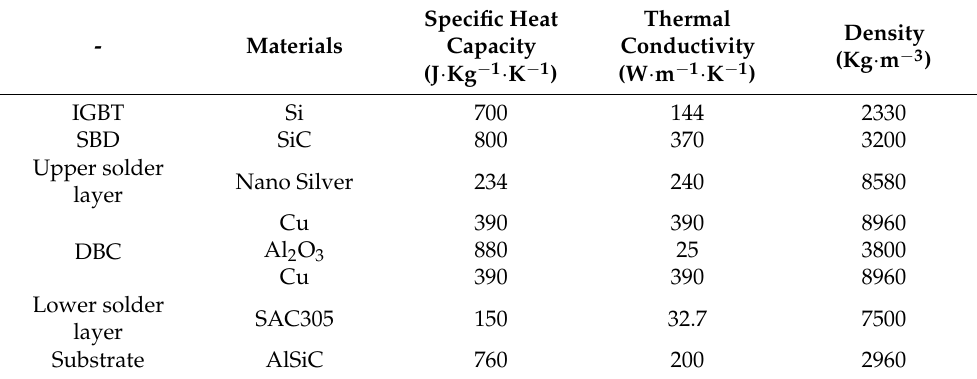
Table 1. Material parameters for each component in the IGBT